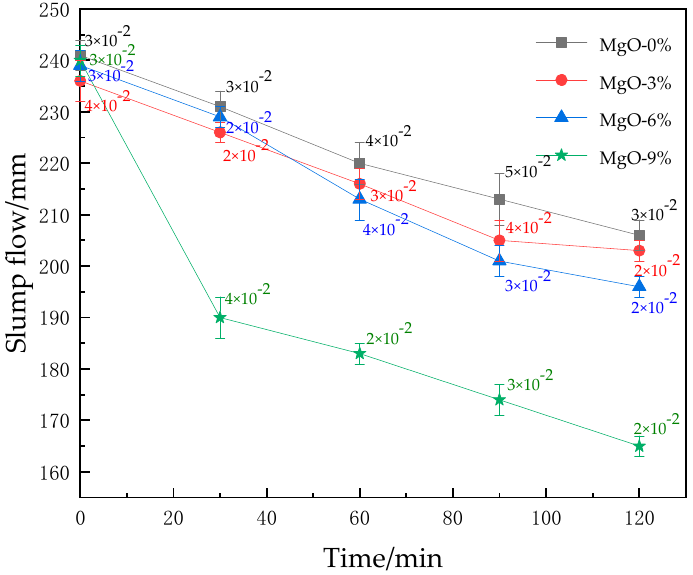
Figure 3. Slump flow of the fresh cement paste.